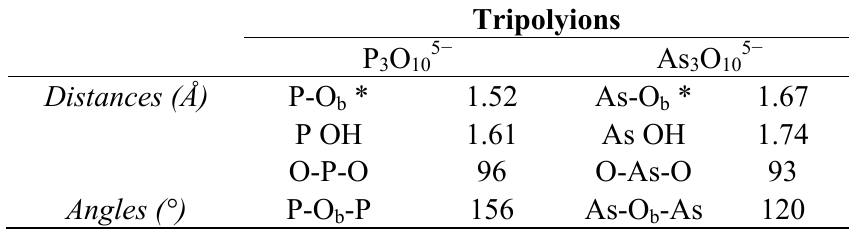
Table 1. Structural Parameters of Tripolyphosphate [7] and Triarsenate [8] Ions.